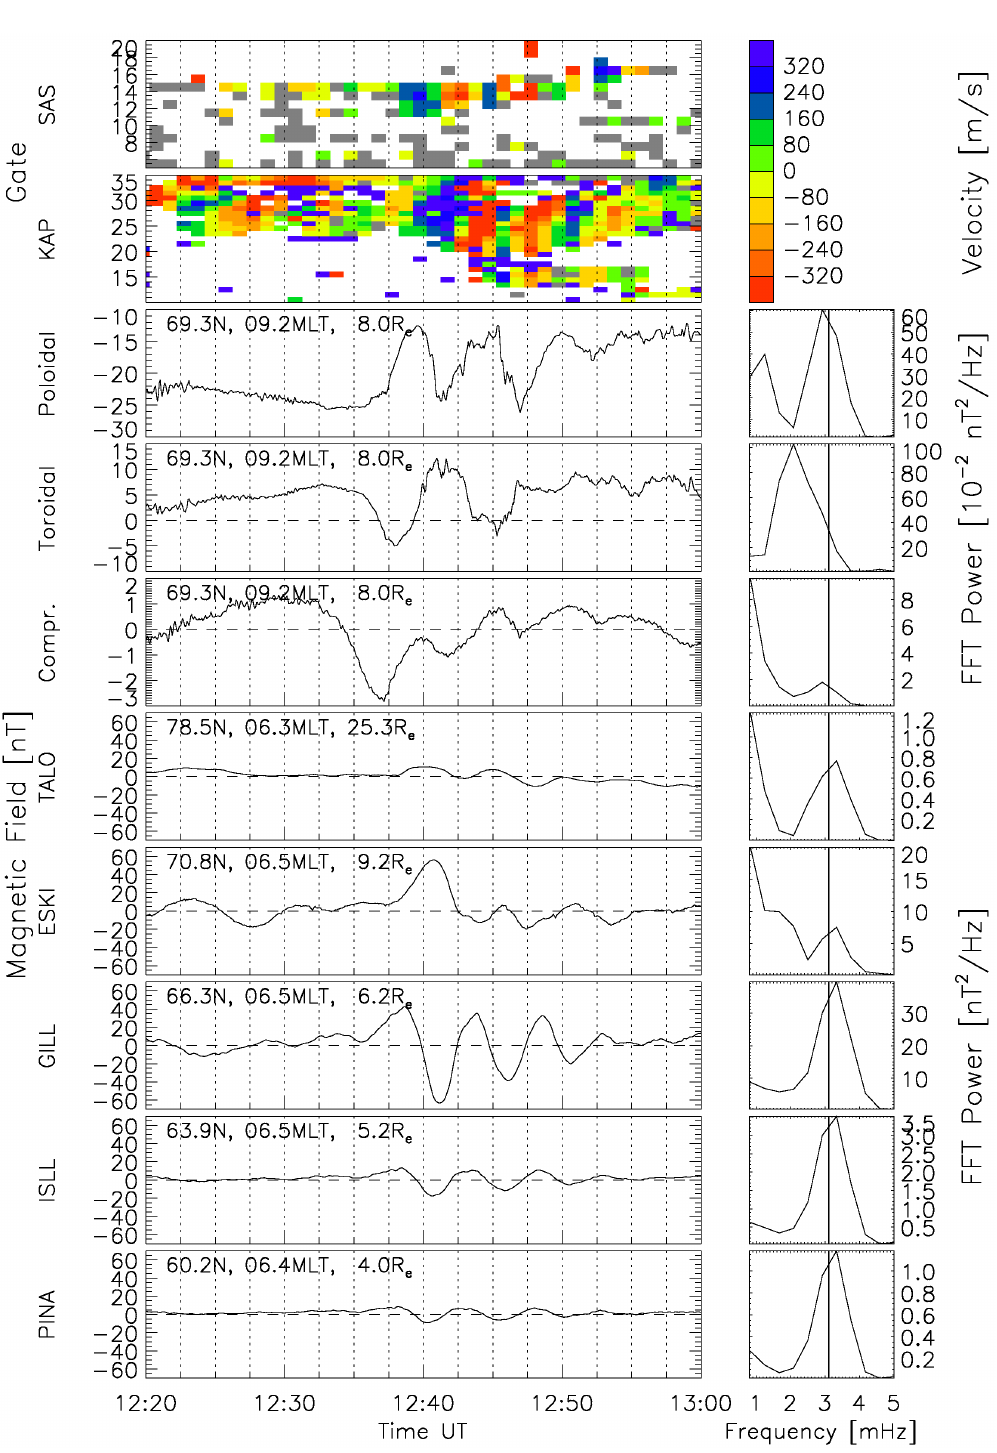
Fig. 3. Ionospheric velocities measured by the Saskatoon and Kapuskasing radar are shown in the top two panels, respectively. The following three panels show magnetic field measurements by s/c 1 in a T96 field-aligned coordinate system. Ground-based magnetometer data from stations along the Churchill line are shown in the bottom five panels. The panels on the right give the respective Fourier spectra. All data are from 24 October